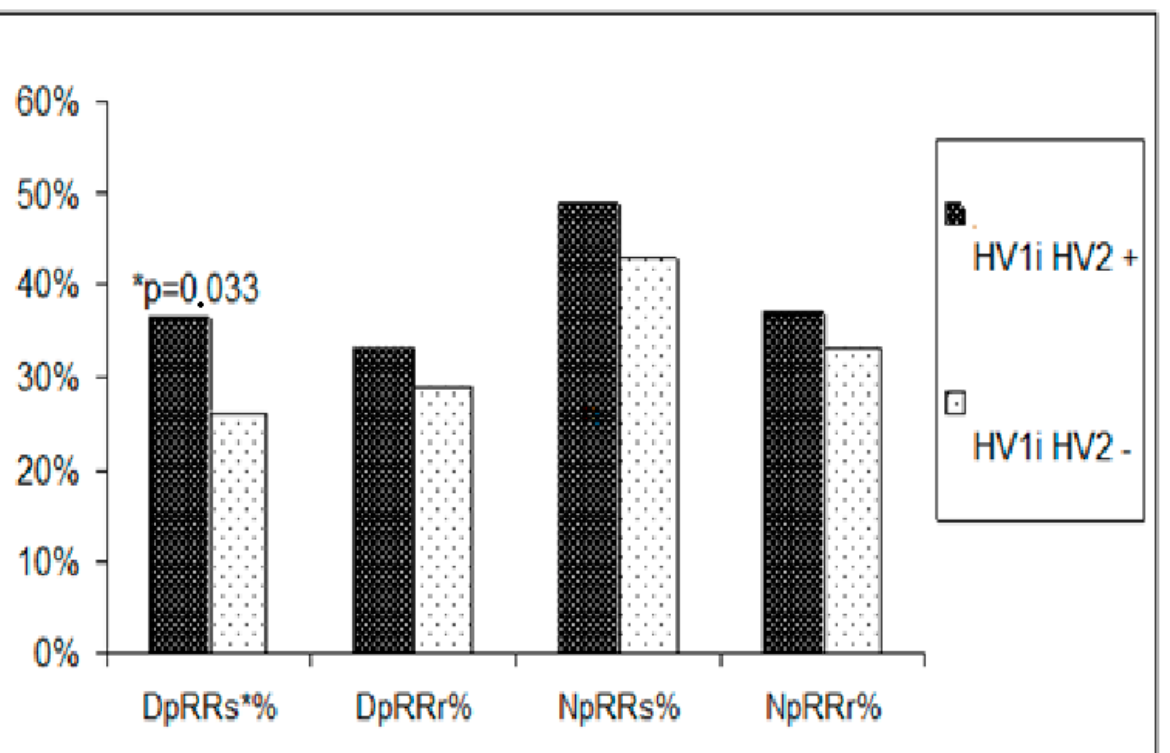
Figure 2. Comparison of the incidence of elevated blood pressure measurements obtained during 24 h blood pressure monitoring in pre- and postmenopausal women with hypertension. DpRRs%- percentage of increased systolic blood pressure values during the day; DpRRr%-percentage of increased diastolic blood pressure values during the day; NpRRs%-percentage of elevated systolic blood pressure values at night; NpRRr%-percentage of elevated diastolic blood pressure values at night. * denotes p value.